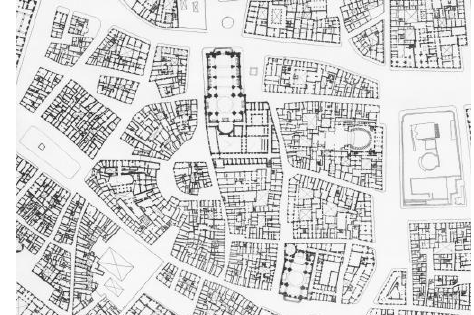
Figure 6. In the reliefs of the ground floors of the area it is possible to see how the walls and the spaces are conditioned by the Roman structure. The substratum is evident and conditions the successive